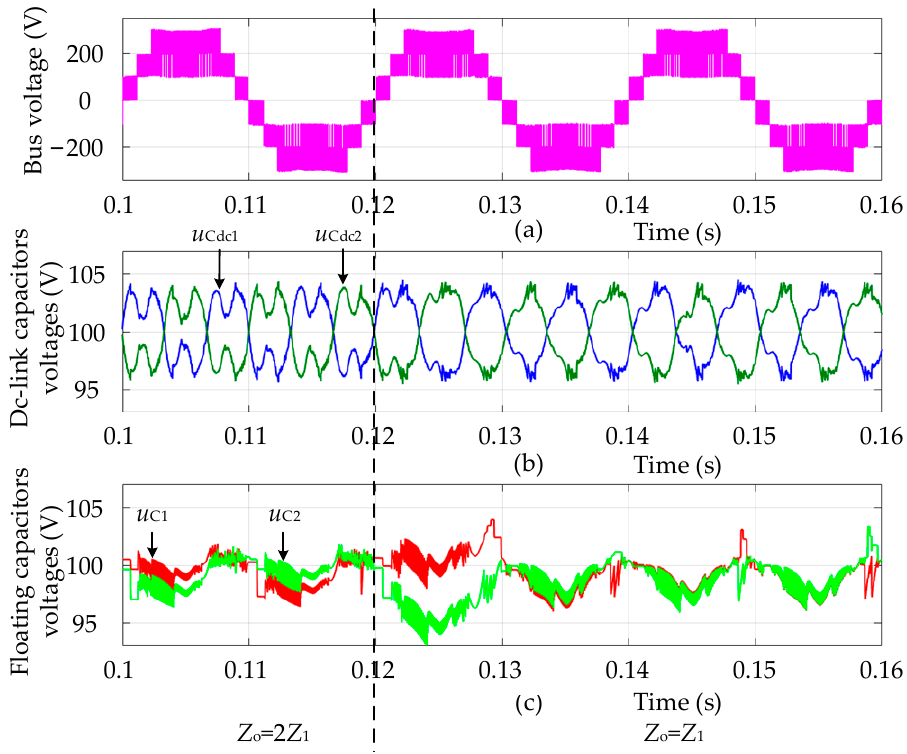
Figure 9. ( a ) The output current of each phase under the resistive–inductive load condition. ( b ) ages were limited to 96–104 V, as before. Figure 13c shows the A-phase floating capacitor voltages. During the same transient process, u C2 was momentarily larger than 105 V. After The FFT result of the A-phase output current. that, the floating capacitor voltages quickly returned to the steady state.